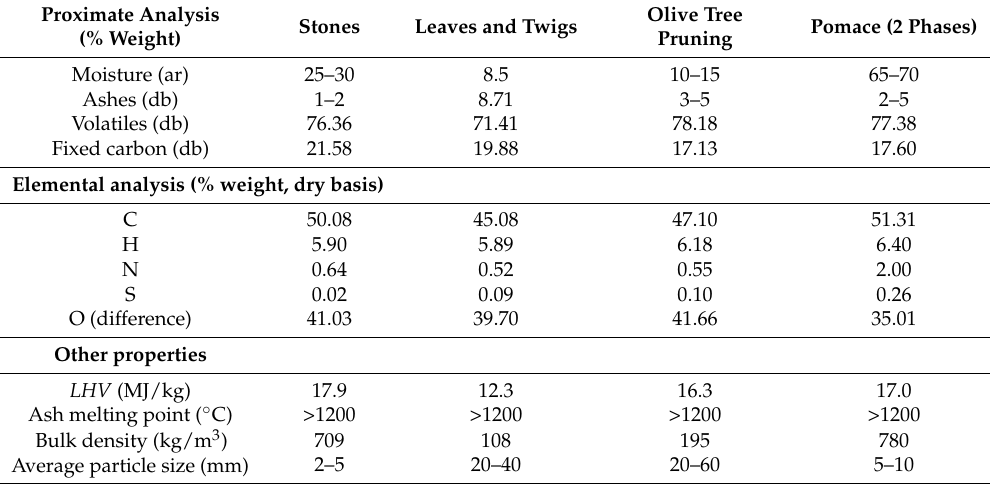
Table 2. Proximate and elemental analyses of the olive industry